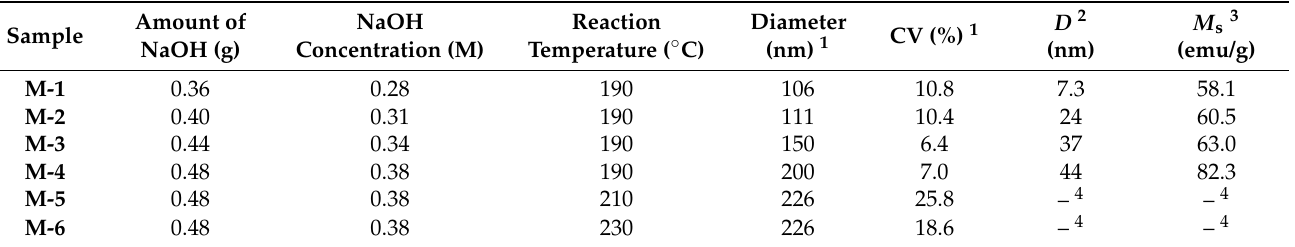
Table 1. Amounts and concentrations of NaOH in the hydrothermal synthesis and size properties and saturation magnetization ( M s ) values of the resultant magnetite